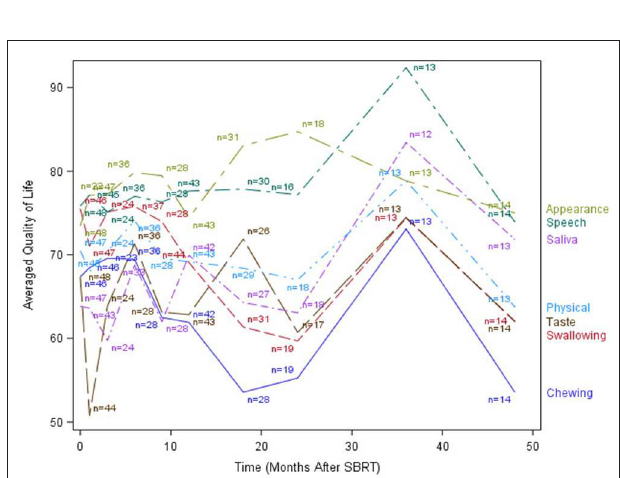
FIGURE 1 | Post-treatment average patient-reported health-related quality-of-life and overall quality-of-life scores. HR-QOL, health-related quality-of-life; QOL, quality-of-life.